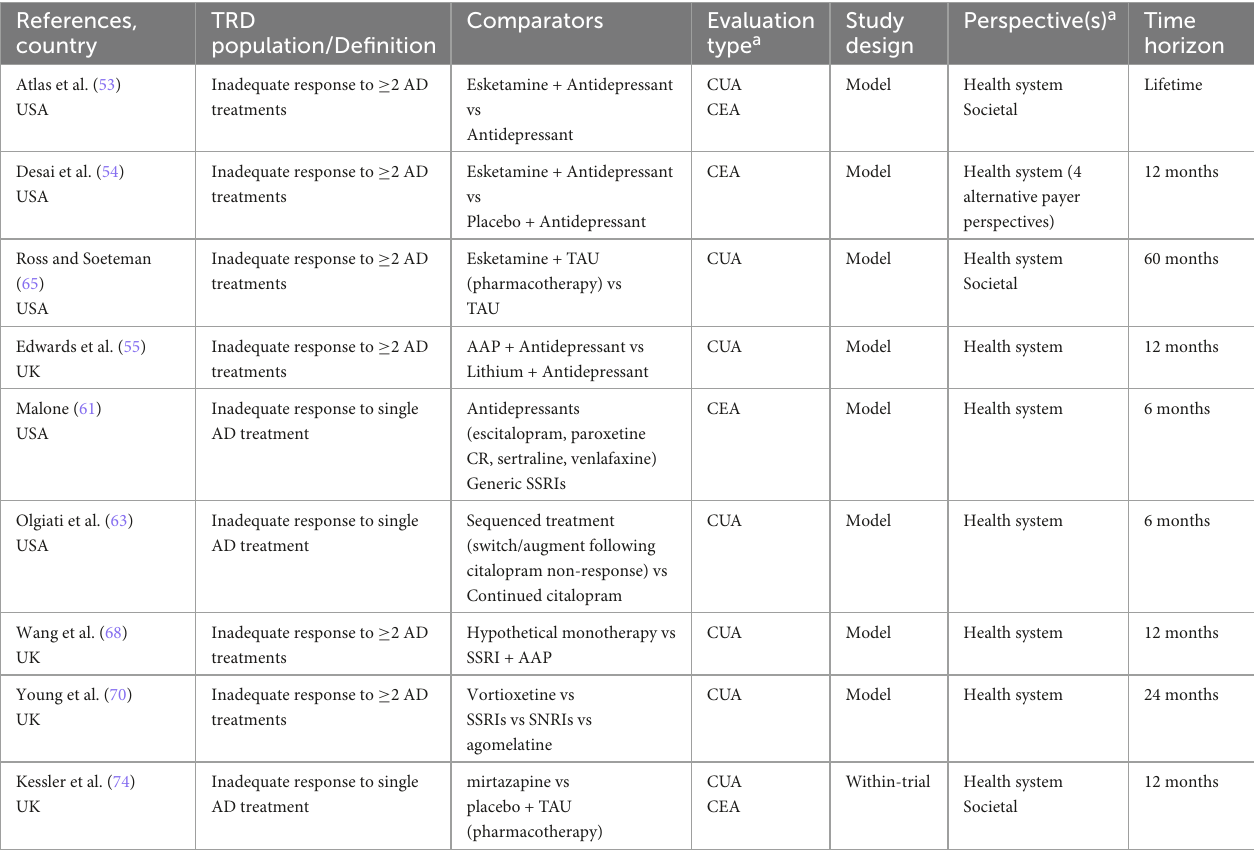
TABLE 2B Characteristics of economic evaluations of pharmacological interventions.